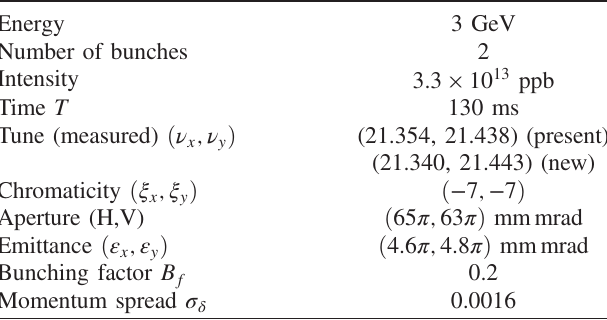
TABLE III. Parameters of the beam loss experiments (emit- tance, bunching factor, and momentum spread are the parameters at beam injection).